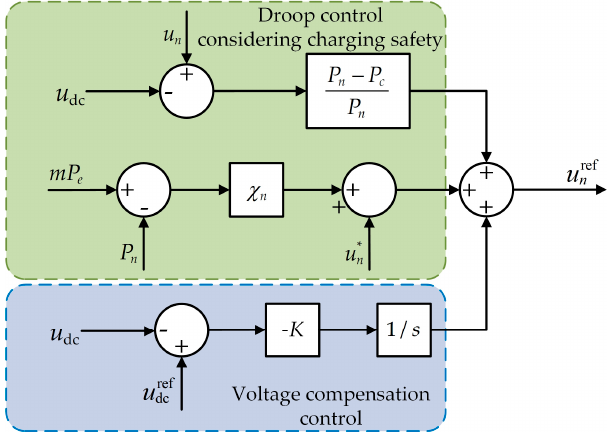
Figure 10. Primary control strategy for the DC microgrid based on improved droop control.